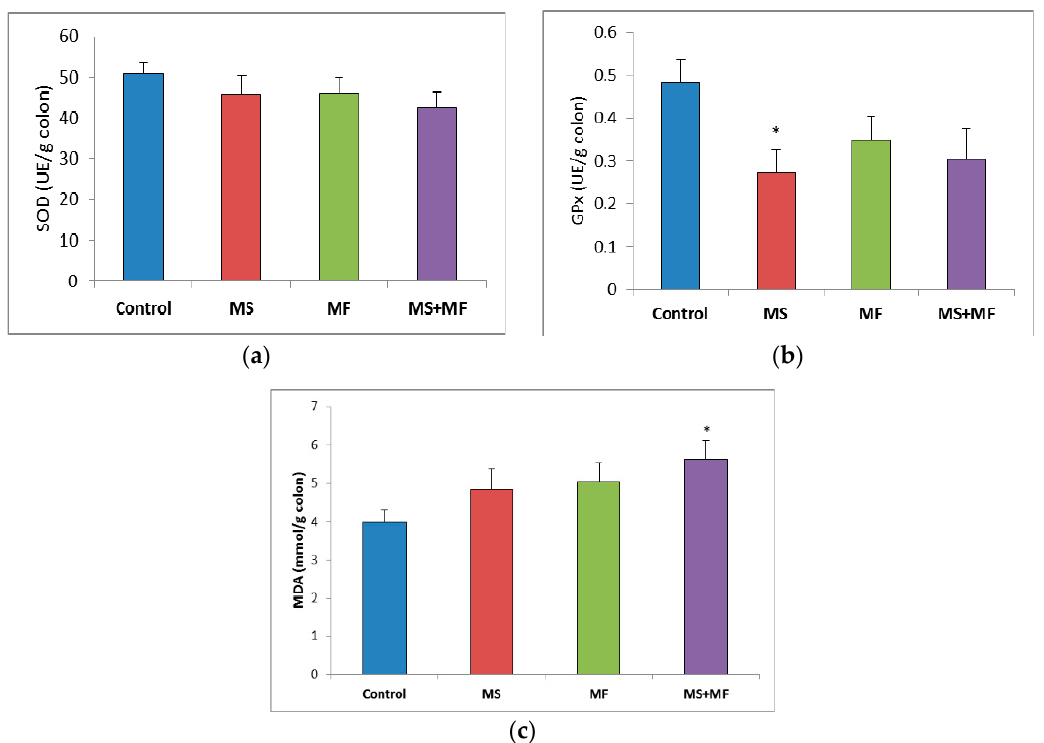
Figure 7. The effect of various combinations of stress factors on oxidative stress markers in the mice bowel tissue: ( a ) SOD activity, ( b ) GPx activity and ( c ) MDA levels. The values are mean ± S.E.M. ( n = 3 per group), * p < 0.05 vs. control, MS = maternal separation, MF = multifactorial stress.